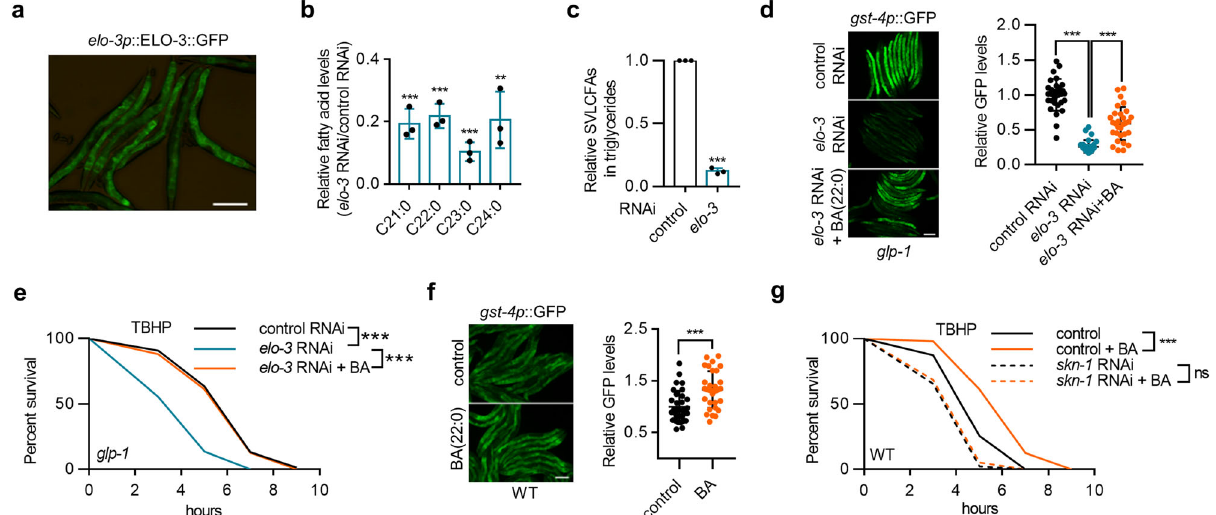
Fig. 2 ELO-3 regulates SKN-1 activity through BA. a The expression pattern of elo-3p ::ELO-3::GFP. b Effects of elo-3 RNAi treatment on the contents of major SVLCFA species in wild-type worms. n = 3 independent experiments. c Effects of elo-3 RNAi treatment on the contents of total SVLCFAs in triglycerides. n = 3 independent experiments. d, e Effects of BA (22:0) supplementation on gst-4p ::GFP expression d ( n = 30 animals) and TBHP resistance ( e ) in glp-1 mutants treated with elo-3 RNAi. f Effects of BA supplementation on gst-4p ::GFP expression in wild-type worms. n = 32 animals. g skn-1 RNAi abrogates the effects of BA supplementation on TBHP resistance in wild-type animals. Data are represented as mean ± SD. ∗∗ p < 0.01, ∗∗∗ p < 0.001. b was analyzed by multiple t -test with correction for multiple comparisons using the Holm – Sidak method ( ∗∗∗ p < 0.001, ∗∗ p = 0.0033). c and f were analyzed by unpaired two-tailed t -test ( ∗∗∗ p < 0.001). d was analyzed by one-way ANOVA with Turkey ’ s multiple-comparison test ( ∗∗∗ p < 0.001). See Supplementary Table 1 for statistical analysis and additional repeats of the survival assays ( e , g ) that were analyzed by log-rank (Mantel – Cox) test. Scale bar = 100 μ m for panels a , d , and f . Source data are provided as a Source Data fi expression of gst-4p ::GFP (Fig. 3a) and SKN-1 target genes (Fig. 3b) and reduced the nuclear occupancy of SKN-1::GFP (Fig. 3c) in glp-1 mutants. Consistently, the enhanced oxidative stress resistance and longevity of glp-1 mutants were largely abolished by sptl-1 RNAi (Supplementary Fig. 3b, c). Notably, the lifespan of the wild-type animals was also reduced signi fi cantly by sptl-1 RNAi (Supplementary Fig. 3c), suggesting that global inhibition of sphingolipid production may cause general sickness.